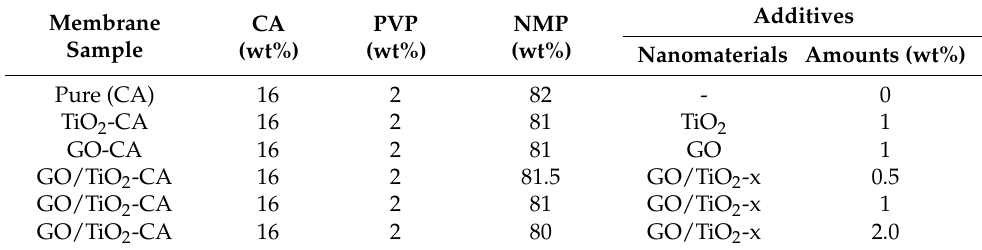
Table 1. The composition of